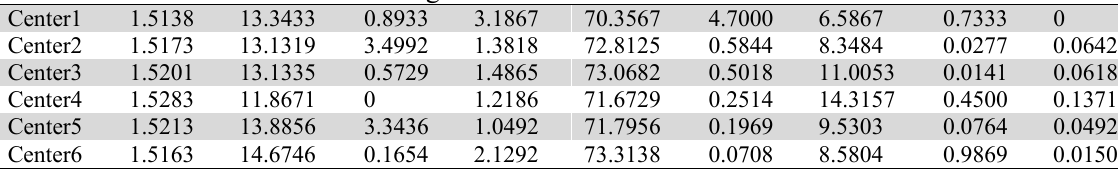
Centers obtained for the best OFV on glass data set Center1